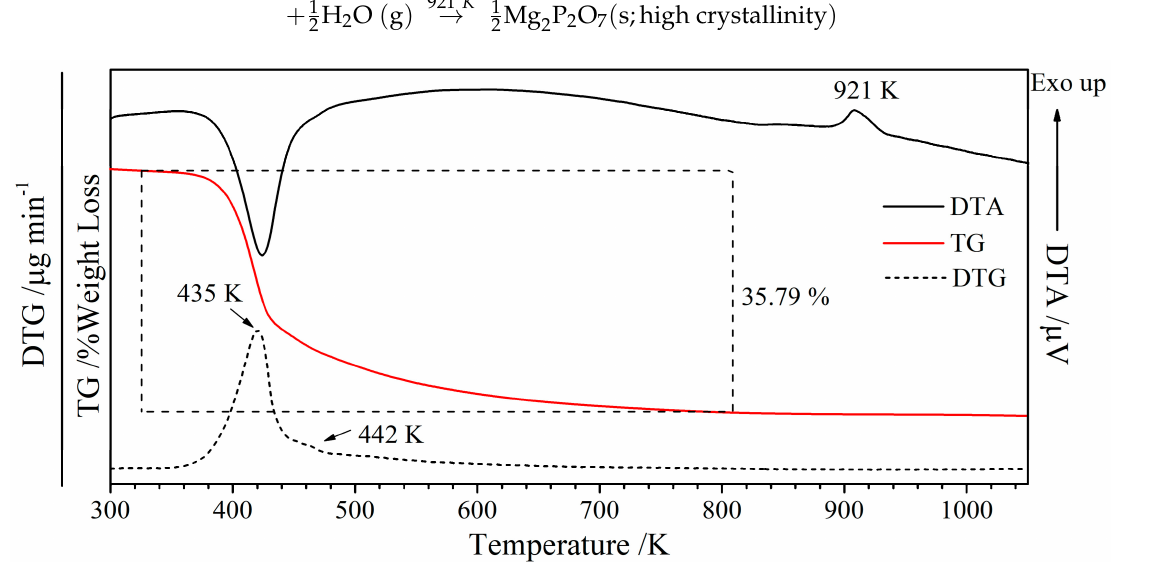
Figure 1. TG/DTG/DTA curves of MgHPO 4 · 3H 2 O at over the temperature range of 303–1073 K at a heating rate of 10 K min − 1 under N 2 atmosphere.